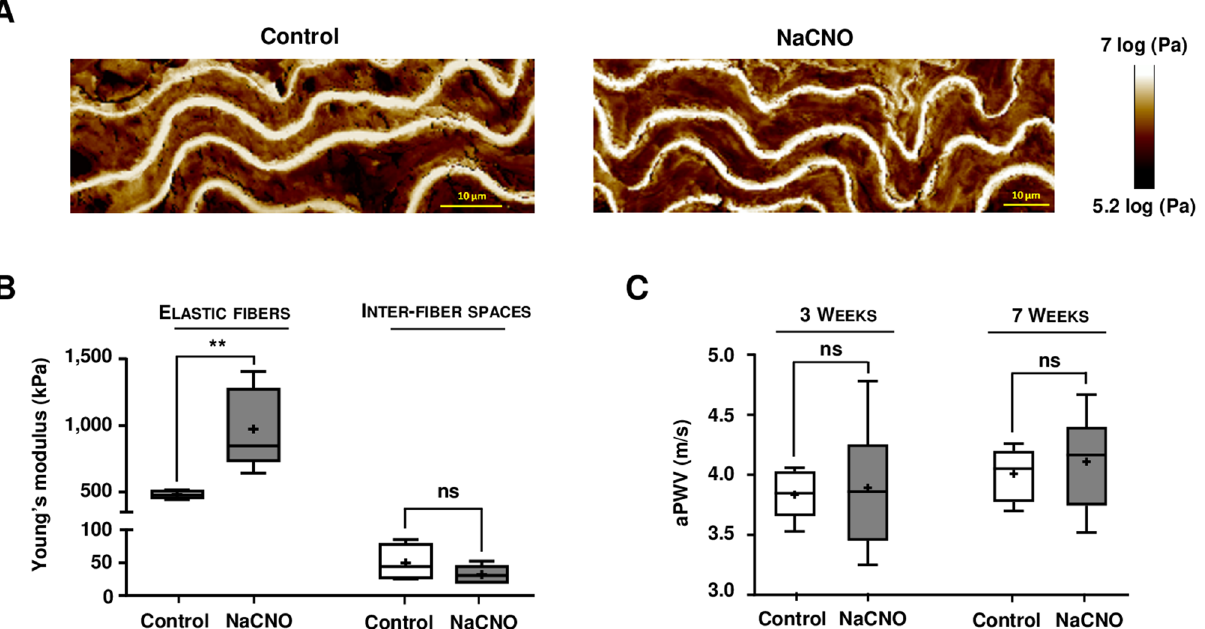
Figure 5. Effect of diet-induced carbamylation on aortic elastic fiber stiffness and aortic pulse wave velocity in WT mice. ( A ) Representative atomic force microscopy pictures showing the Young’s modulus (YM) were acquired in 10 μm cross-sections of WT mice aortas using a Peak Force QNM mode. Mice were fed for 3 weeks with water supplemented with 1 mM NaCl (control) or 1 mM NaCNO. ( B ) Quantification of the YM [expressed in kilopascals (kPa)] was carried out directly on elastic fibers and on the inter-fiber spaces. ( C ) Aortic pulse wave was measured at the thoracic and abdominal levels by two Doppler probes in WT mice. Results of aortic pulse wave velocity (aPWV) were expressed in meters per second (m/s). For ( B ) and ( C ), results were presented as boxplots, in which the error bars represent minimum and maximum values, the horizontal bars and the crosses indicate median and mean values, respectively, and the extremities of the boxes indicate interquartile ranges. Values were compared using the non-parametric Mann–Whitney’s U test ( ns not significant, ** p < 0.01).